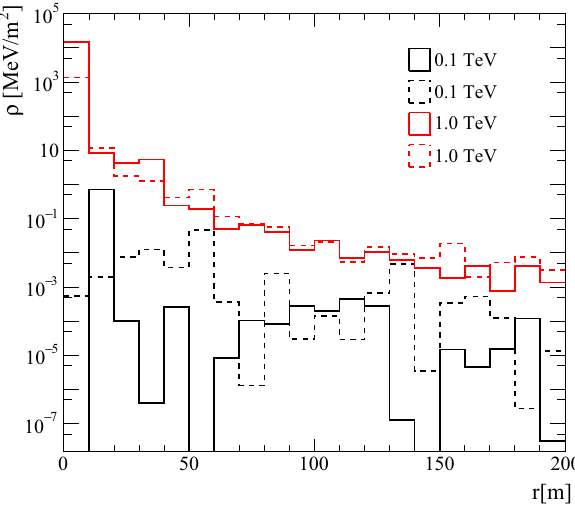
Fig. 10 Electromagnetic energy density ρ as a function of distance